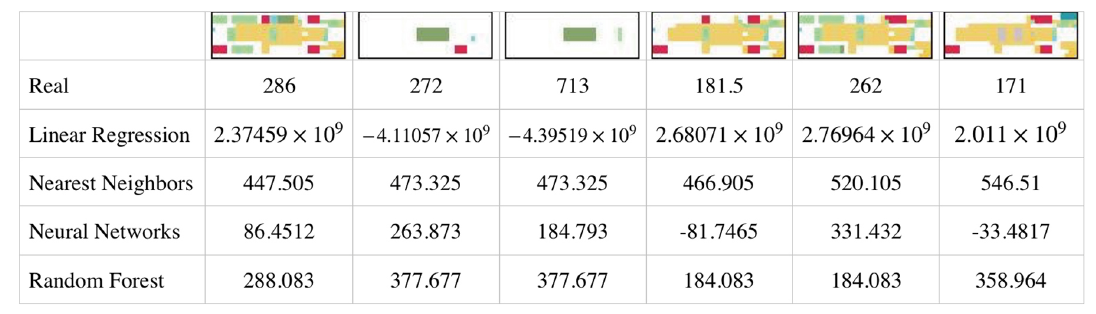
Figure 10. The prediction table for the five configurations used to test the methods.